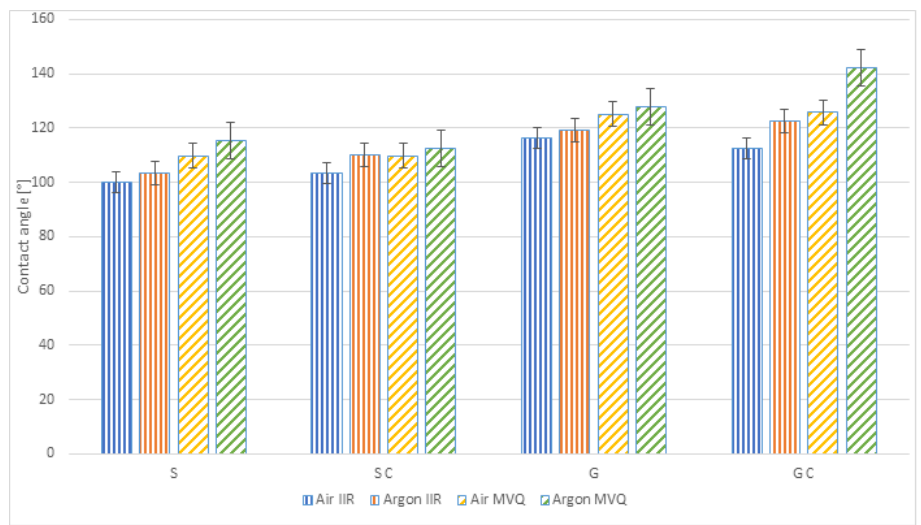
Figure 4. Contact angles of the analysed polymer materials (S — smooth samples, SC — chemically modified smooth samples, G — geometrised samples, GC — chemically modified geometrised sam-